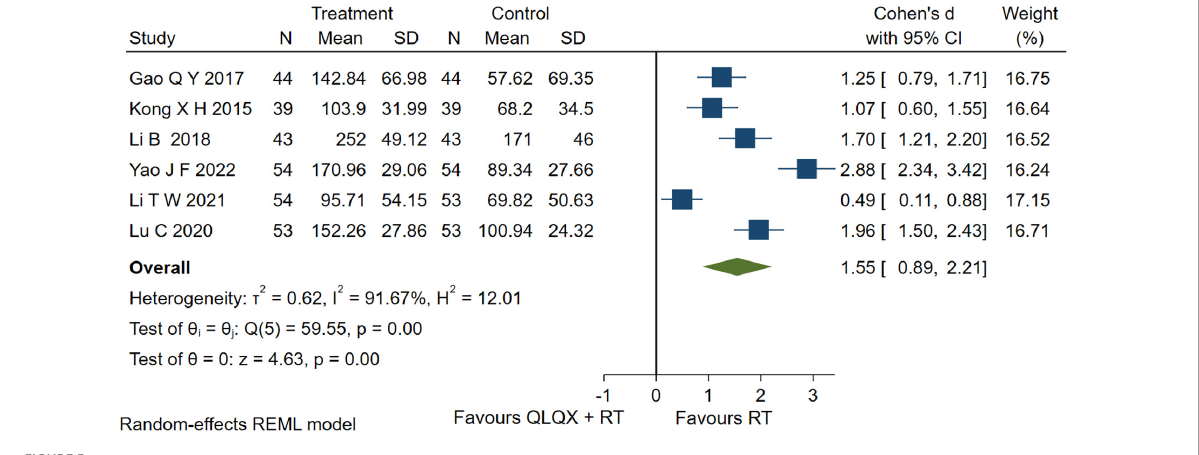
FIGURE5 Forest plot of 6-min walk distance.